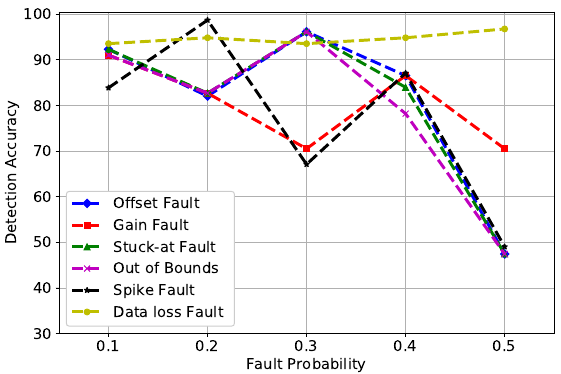
Figure 4. MLP detection accuracy of fault